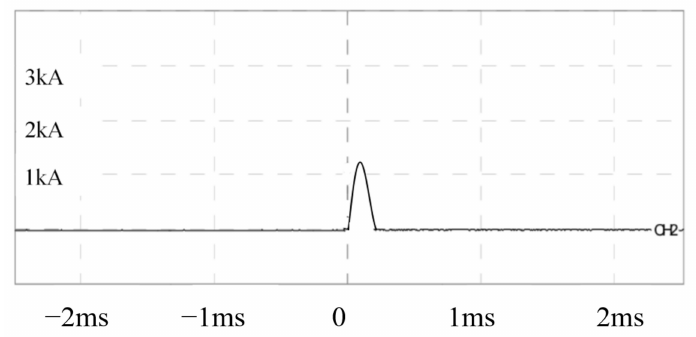
Figure 14. Arc current waveform.